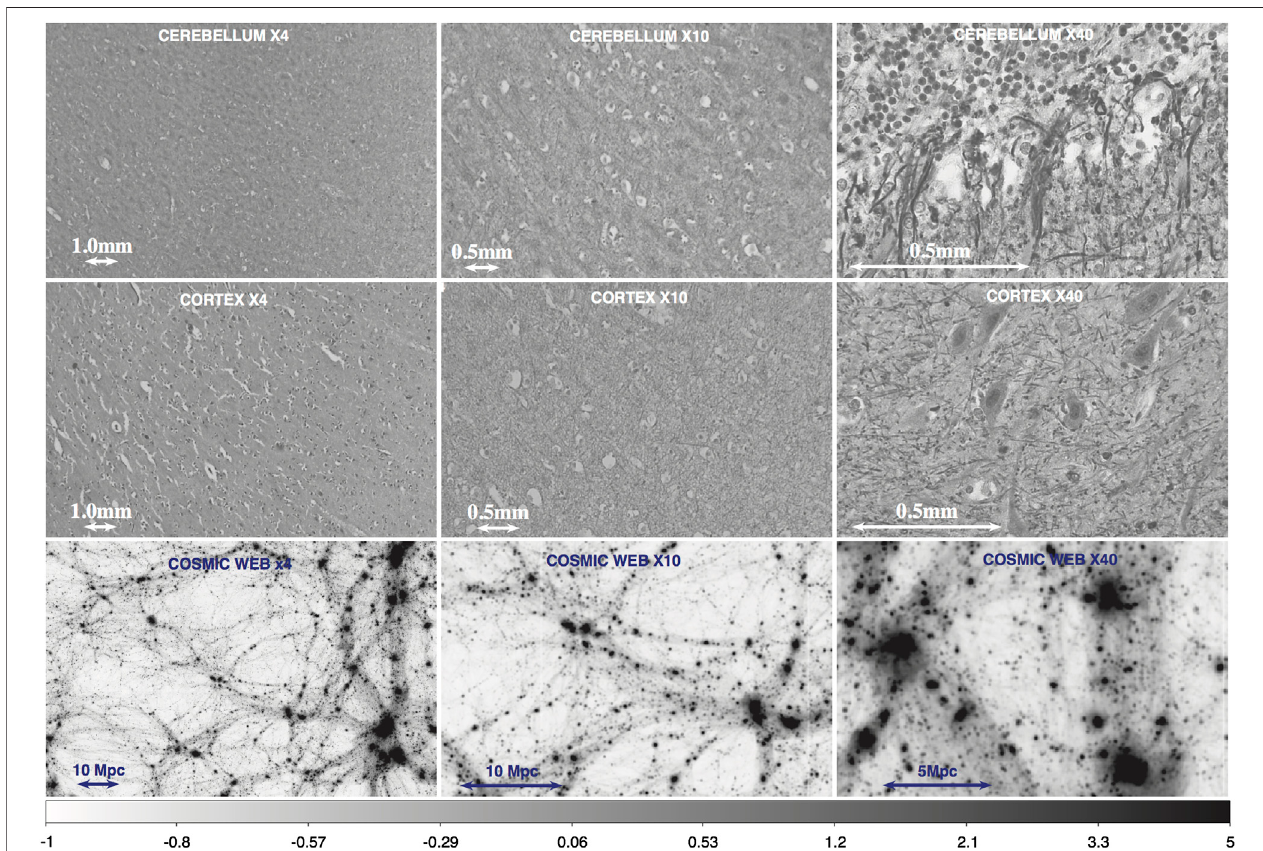
FIGURE 1 | Maps of normalized density contrast, δρ for examples of slices of the cerebellum (top row), of the brain cortex (middle row) and of the dark matter distribution ofthe cosmic web (lower row), forvariouslevels ofmagni fi cation. The spectraland network analysis presented in this work will mostly focus on 40 × samples as in the right